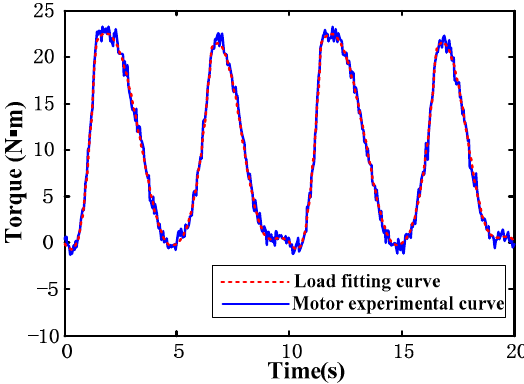
Figure 6. Load fitting curve and motor torque experimental curve.